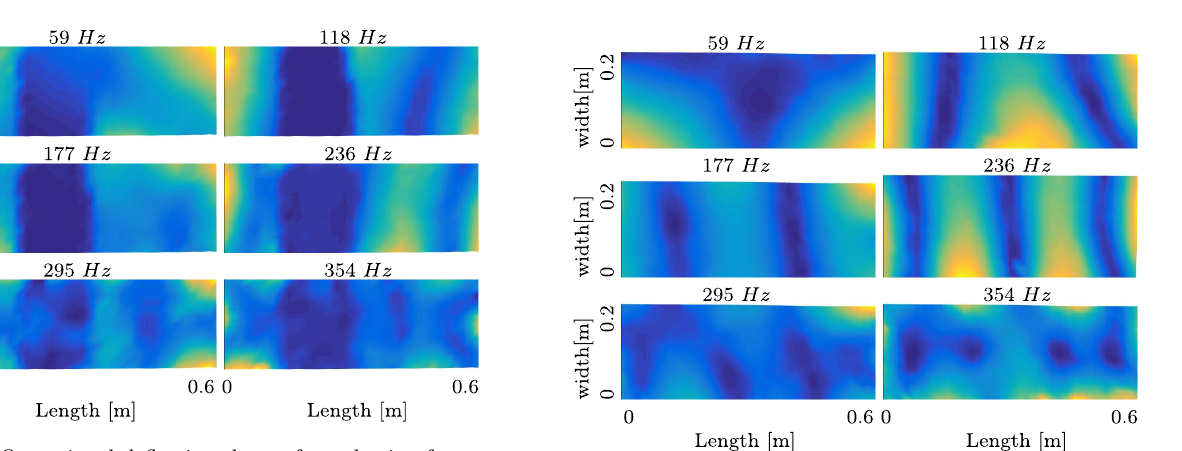
Figure 9. Operational de fl ection shapes for pulsation frequen- cies of the segment with straight tube on the surface (Fig. 6.I).